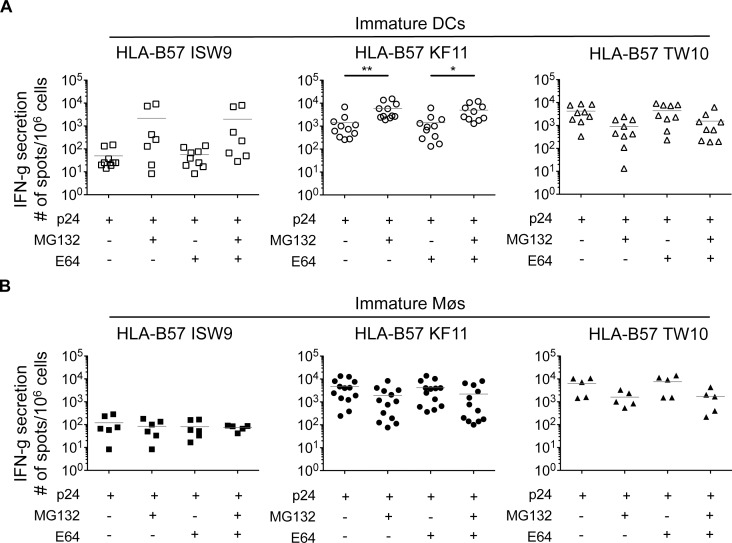
Inhibition of proteasomes increases B57-KF11 and B57-ISW9 epitope cross-presentation by DCs but not Møs (A) Immature DCs (open symbols) and (B) immature Møs (solid symbols) were pretreated with proteasome inhibitor (MG132) or a broad inhibitor of cysteine proteases (E64) before addition of recombinant HIV-1 p24 protein.CTL responses to HLA-B57 ISW9-specific (☐), KF11-specific (○), and TW10-specific (Δ) were measured as described in Fig. 1. Similarly, incubation of DCs with epoxomicin, a selective chymotrytpic proteasome inhibitor, increased HLA-B57-KF11-specific CTL responses by 11-fold. Results are from n≥5 donors.